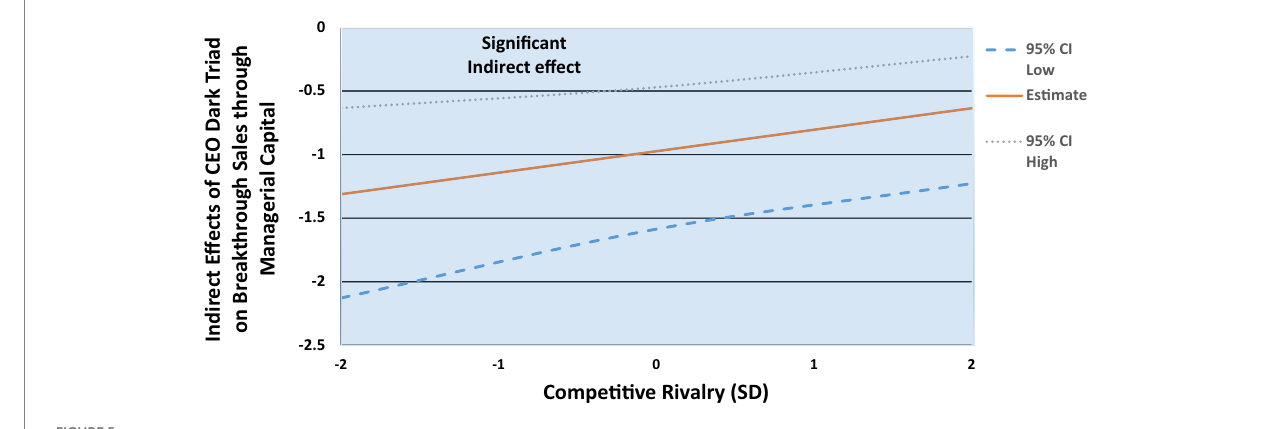
FIGURE 5 Indirect effects of CEO dark triad on breakthrough sales through managerial capital, conditional on competitive rivalry.